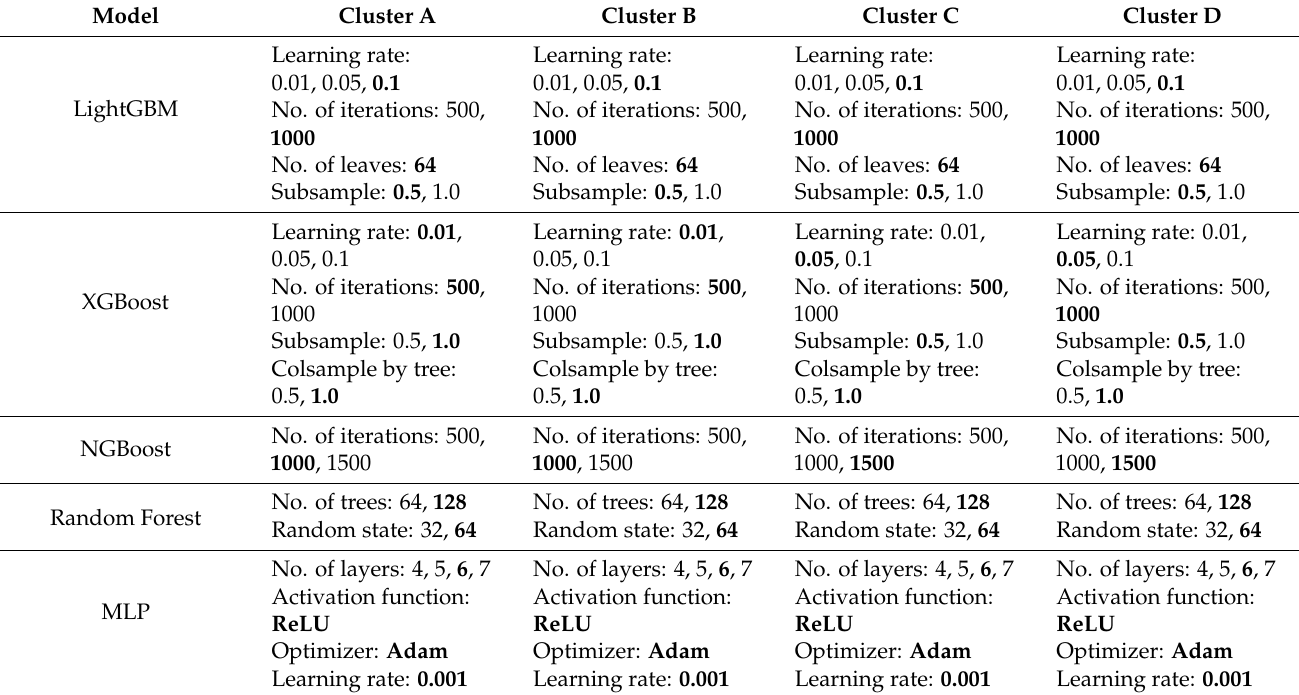
Table 3. Selected hyperparameters for each single-output forecasting model. Selected values are bold. Model